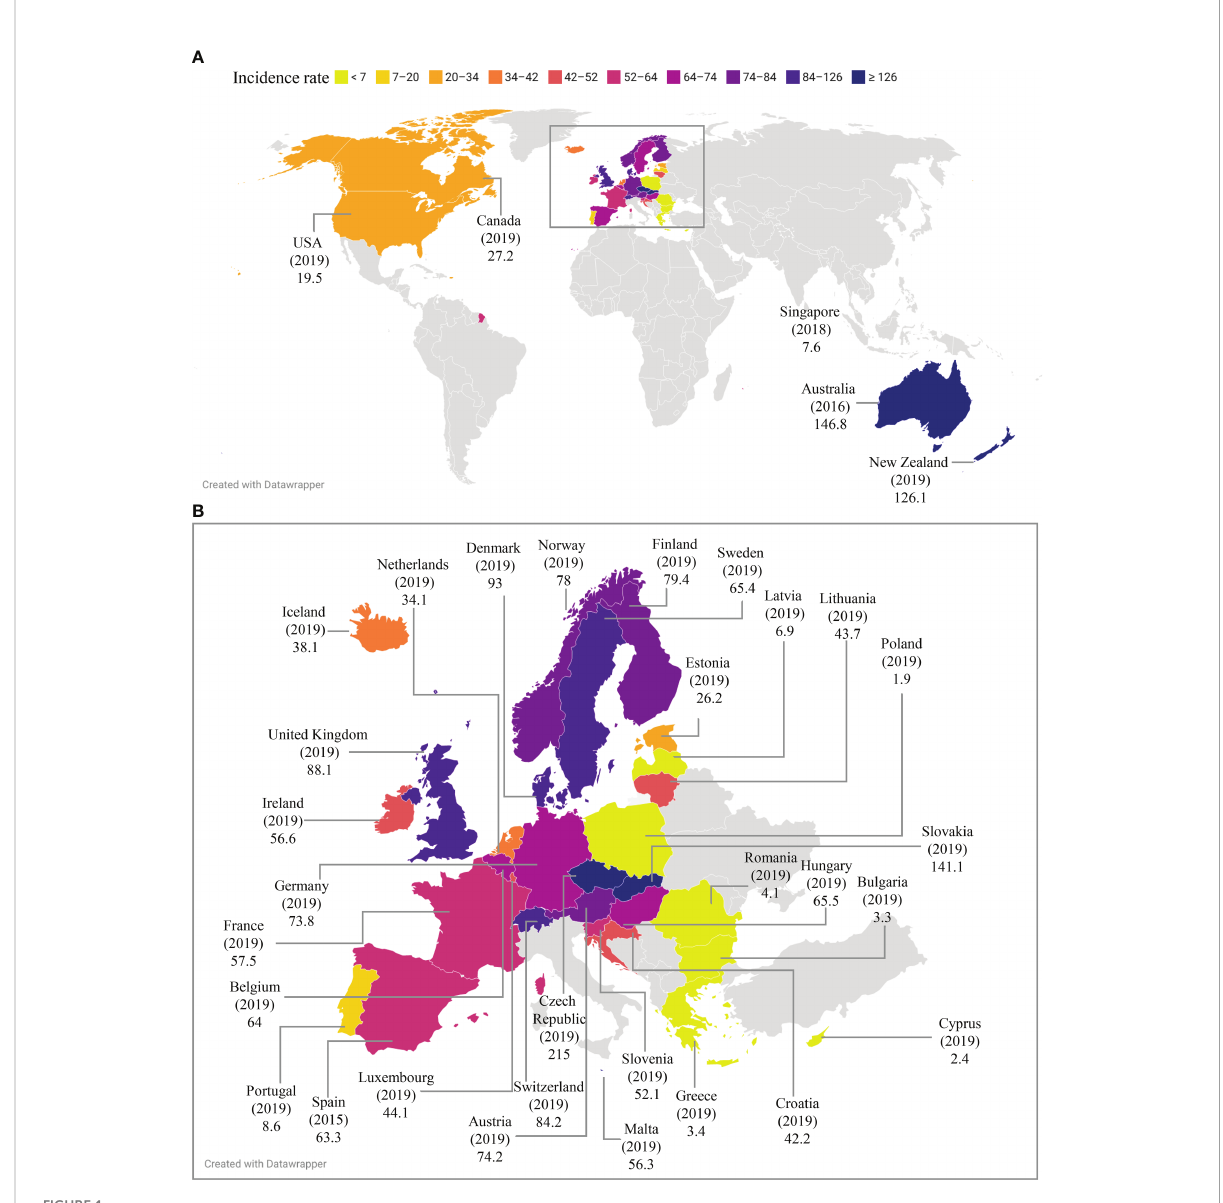
FIGURE 1 Reported global incidence of campylobacteriosis. Reported incidence rates of campylobacteriosis worldwide (A) and in Europe (B) are presented as per 100,000 population. Data presented in the fi gure were mainly from 2019. In countries where the 2019 data were not available, data from a previously available year were used. Countries with no reported incidence of campylobacteriosis available were in grey colour. Map was created with